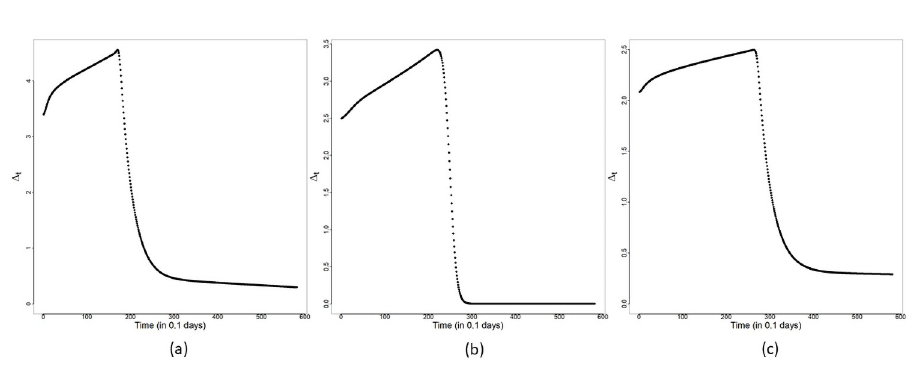
Fig 9. Modified SEIR model: Δ